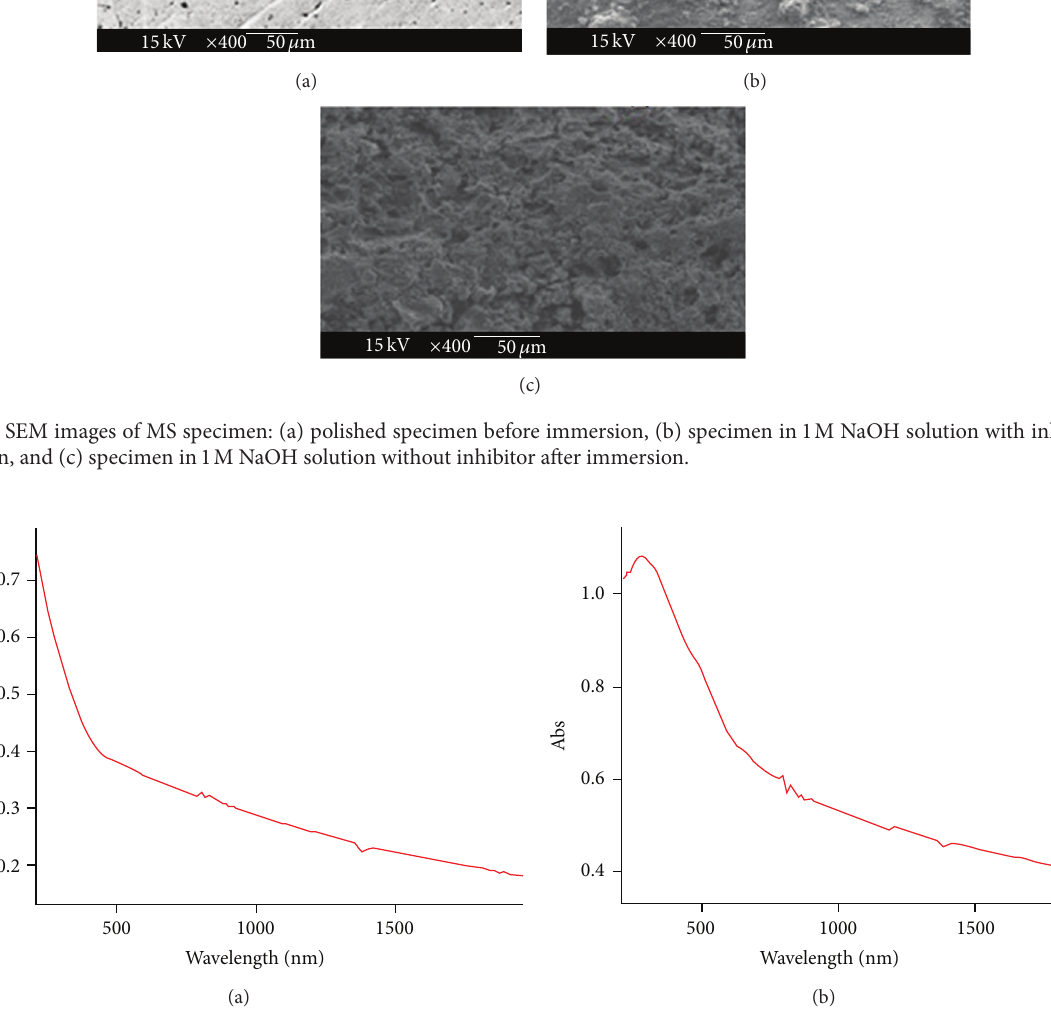
Figure 4: UV-spectra of MS specimen in inhibitor added 1M NaOH solution (a) before immersion and (b) after